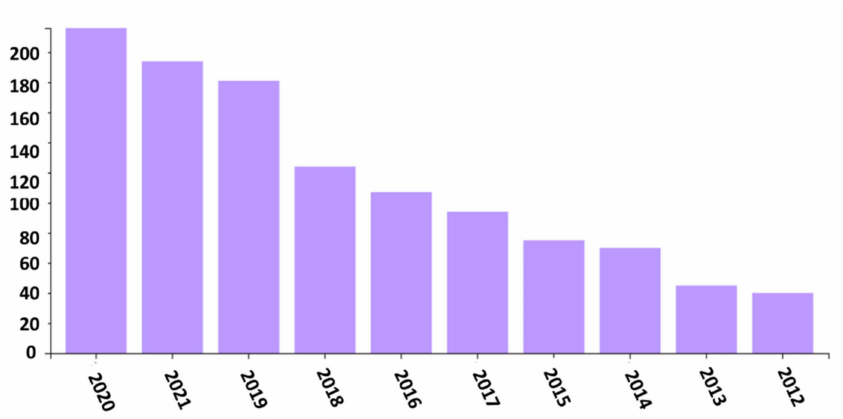
Figure 1. Recent publications related to electrospinning for wound dressing (September